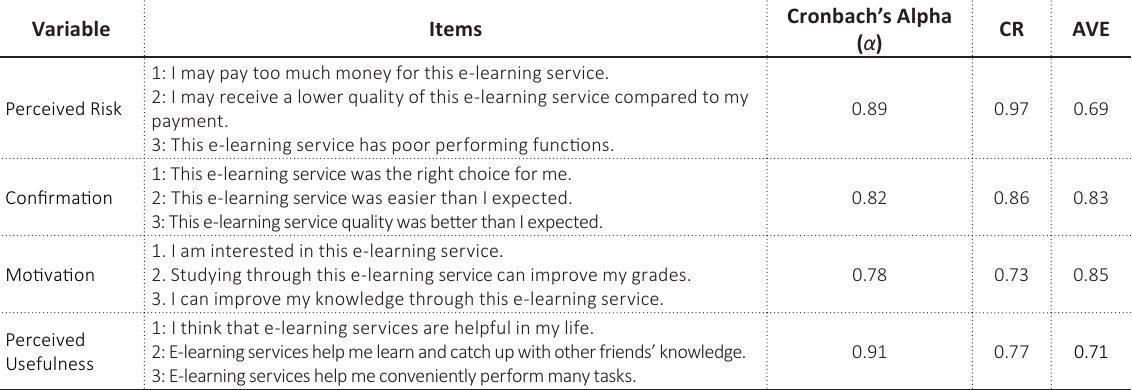
Table 2. Discriminant validity